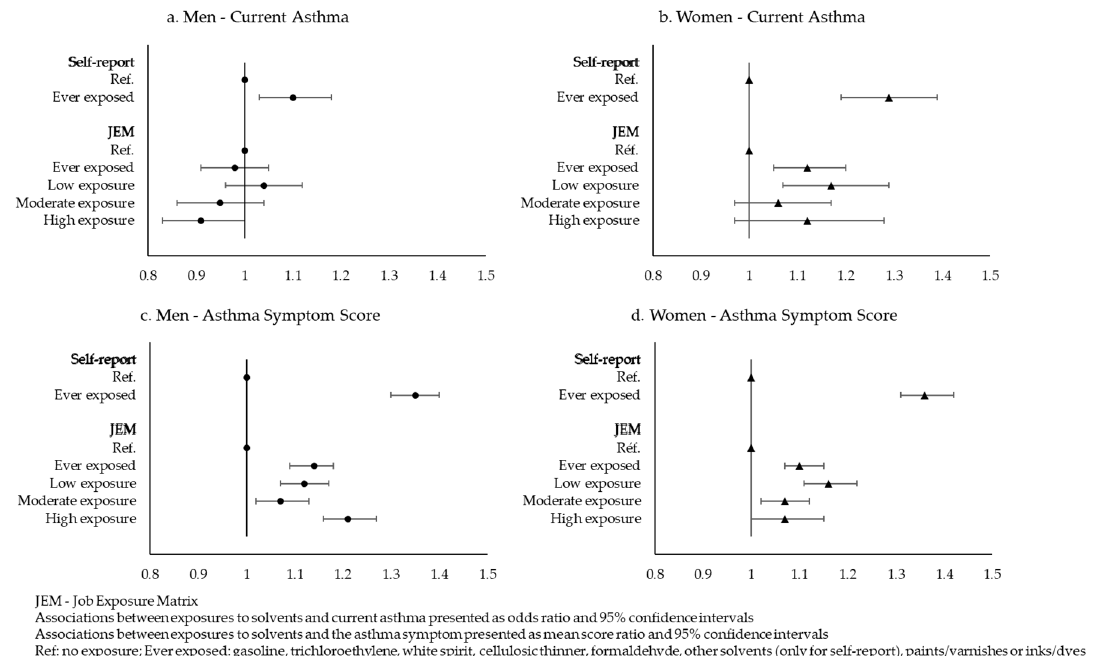
Figure 1. Association between lifetime exposures to at least one solvent assessed by self-report or JEM and current asthma or asthma symptom score.